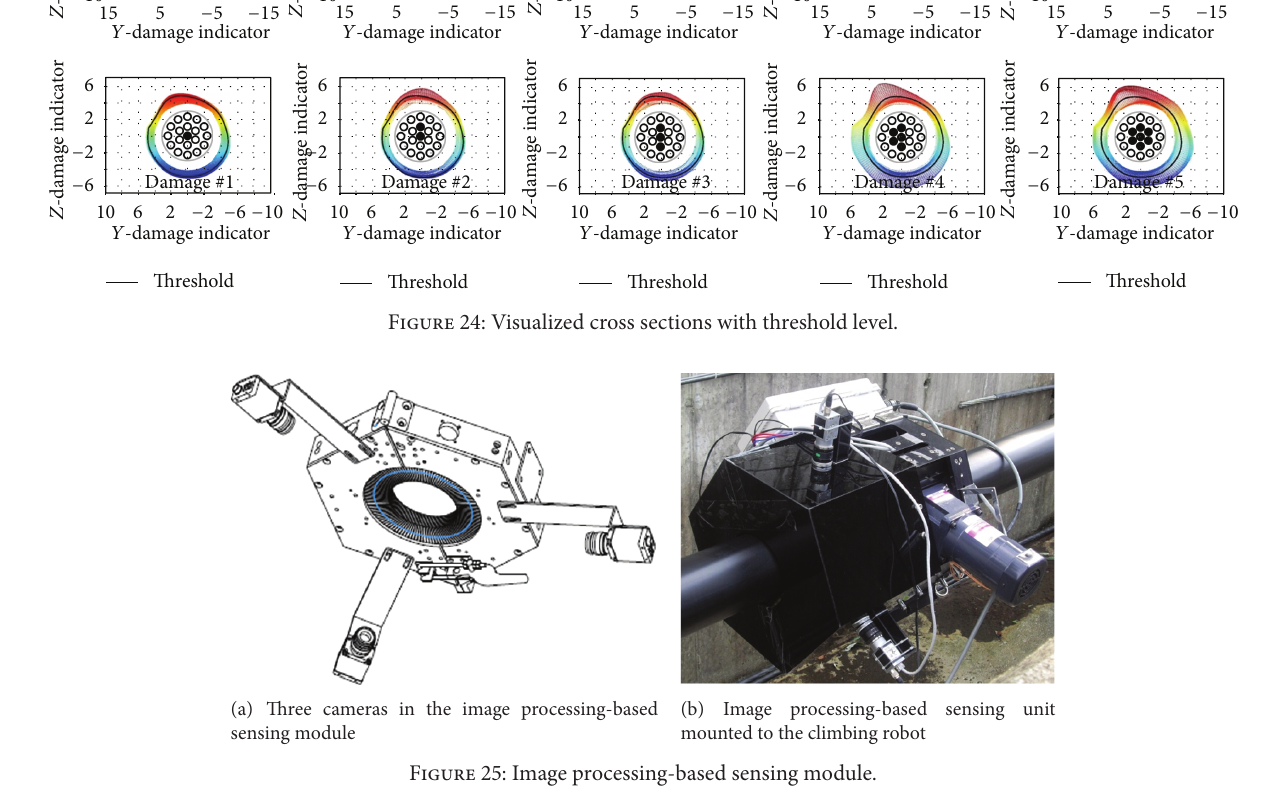
Figure 25: Image processing-based sensing module.